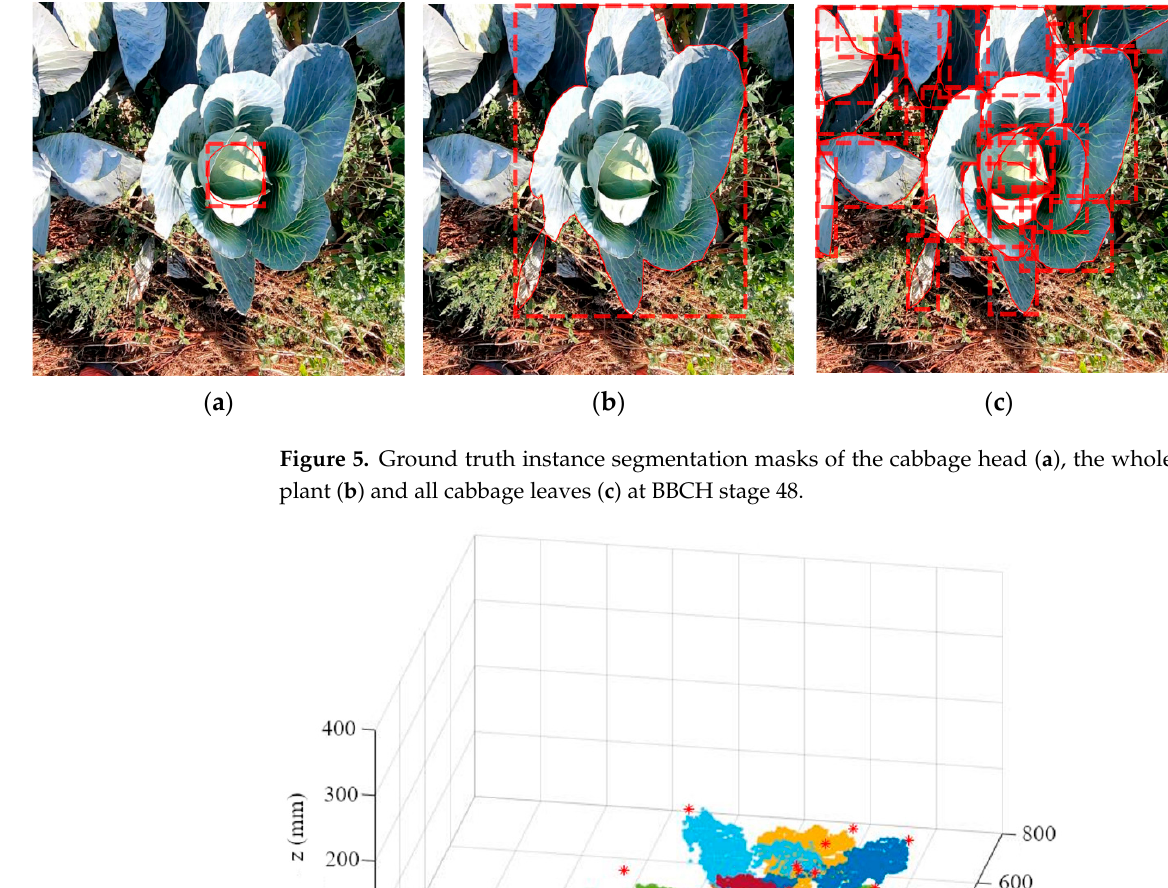
Figure 5. Ground truth instance segmentation masks of the cabbage head ( a ), the whole cabbage plant ( b ) and all cabbage leaves ( c ) at BBCH stage 48 .